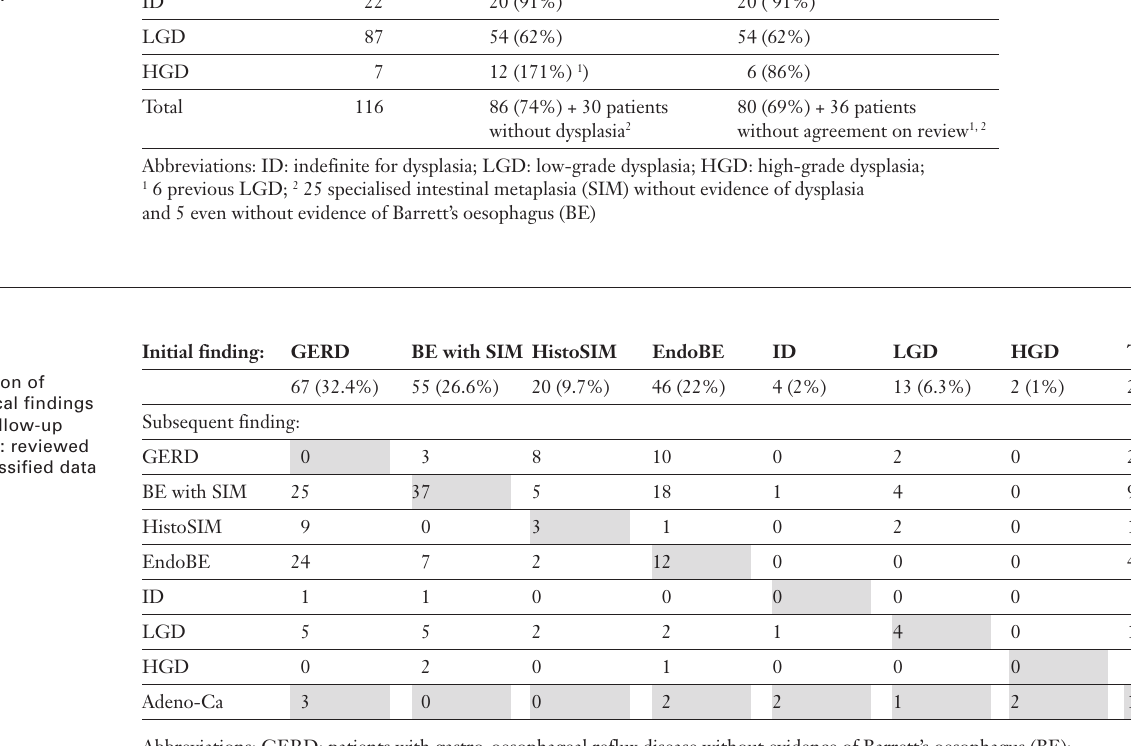
The dark columns represent oesoph- ageal biopsies as a percentage of oesophageal endo- scopies per year. White columns show BE in percent of endoscopies with a slight increase from 4–6%, whereas the dark line represents BE in percent of oesophageal biop- sies with a marked increase from 10–20% of biopsies over the study pe-